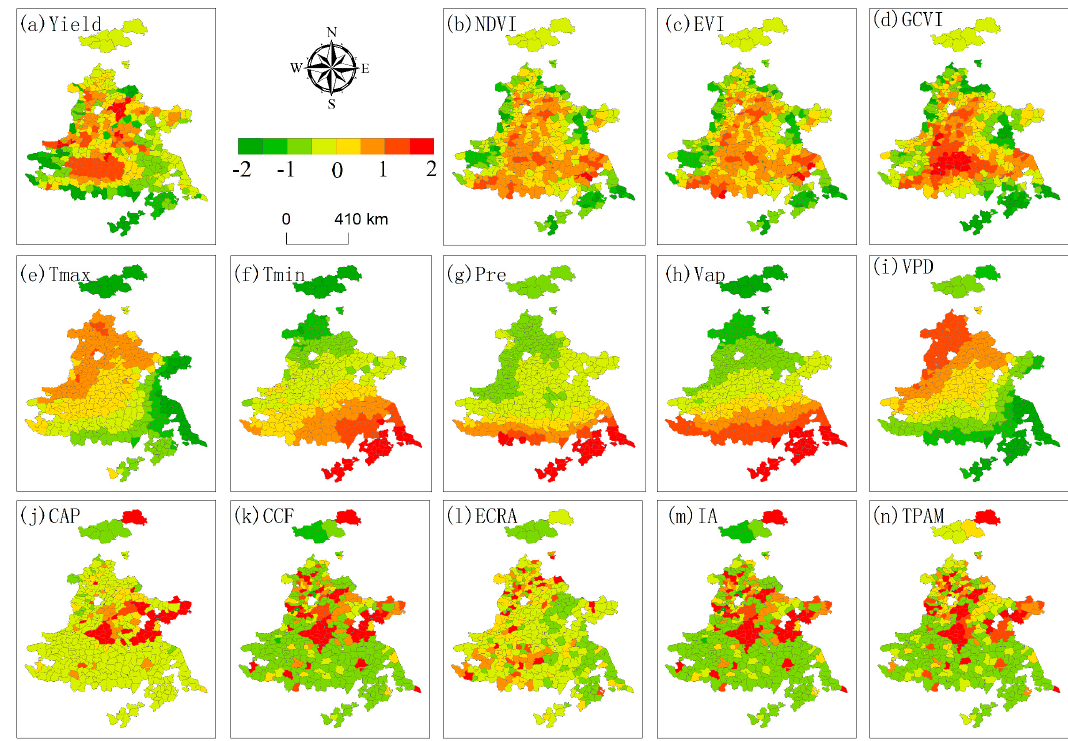
Figure 3. Fifteen-year-averaged (2001–2015) spatial patterns after normalization of crop yield ( a ), the satellite-based variables ( b – d ), climate variables ( e – i ), socio-economic factors ( j – n ) and for all counties in the study region. Note: all of the data have a mean of zero and standard deviation of one; b–i are based on March of every year.